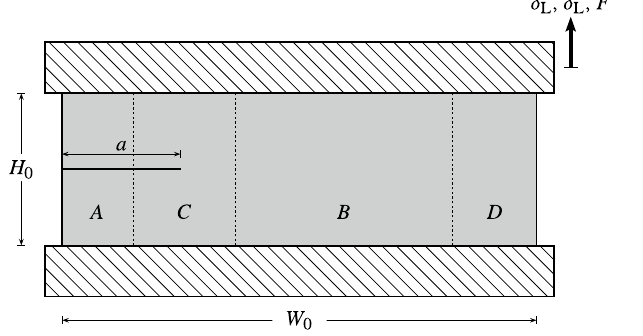
Figure 1. The schematic of the pure shear tear